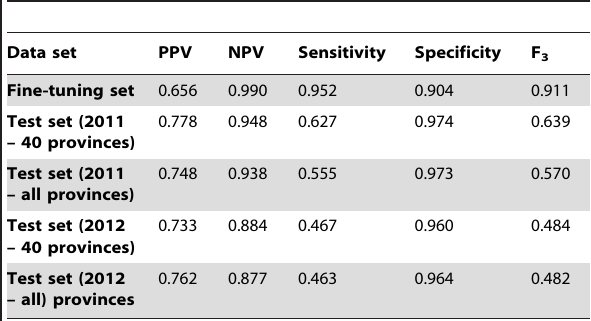
Table 5. FARM prediction results for Philippines